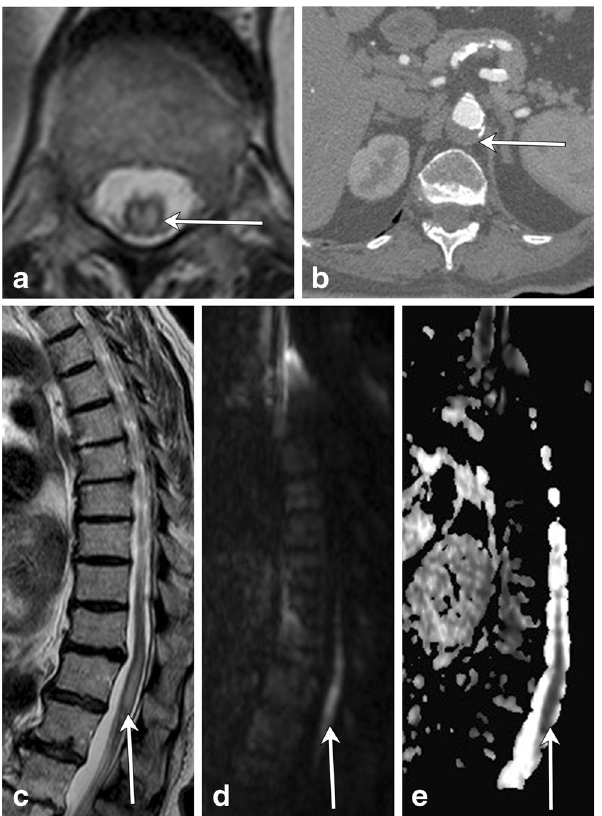
Fig. 22 Spinal cord infarction. An 82-year-old female with hypertension and hyperlipidaemia presents with acute bilateral lower extremity weak- ness. a Axial T2 image demonstrates a large cross-sectional area of hyperintensity (arrow) within the thoracic cord. b Axial CT angiogram image shows mural thrombus within the aorta (arrow) at the same level of the spinal cord findings with no appreciable filling of the lumbar arteries. Sagittal T2 ( c ), DWI ( d ) and ADC ( e ) images reveal a long-segment intramedullary lesion in the lower cord (arrows) that is T2 hyperintense and has restricted diffusion